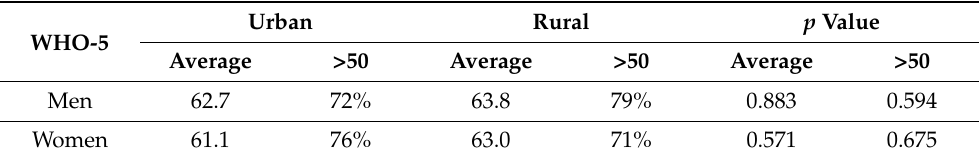
Table A1. WHO-5 average score attending to sex and living environment (rural vs. urban). Statistical comparison between rural and urban environments in the score obtained in the WHO-5 aggregating by sex.